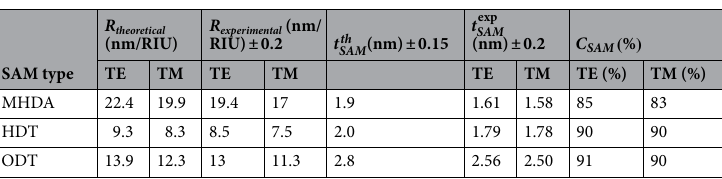
th SAM , is given by the